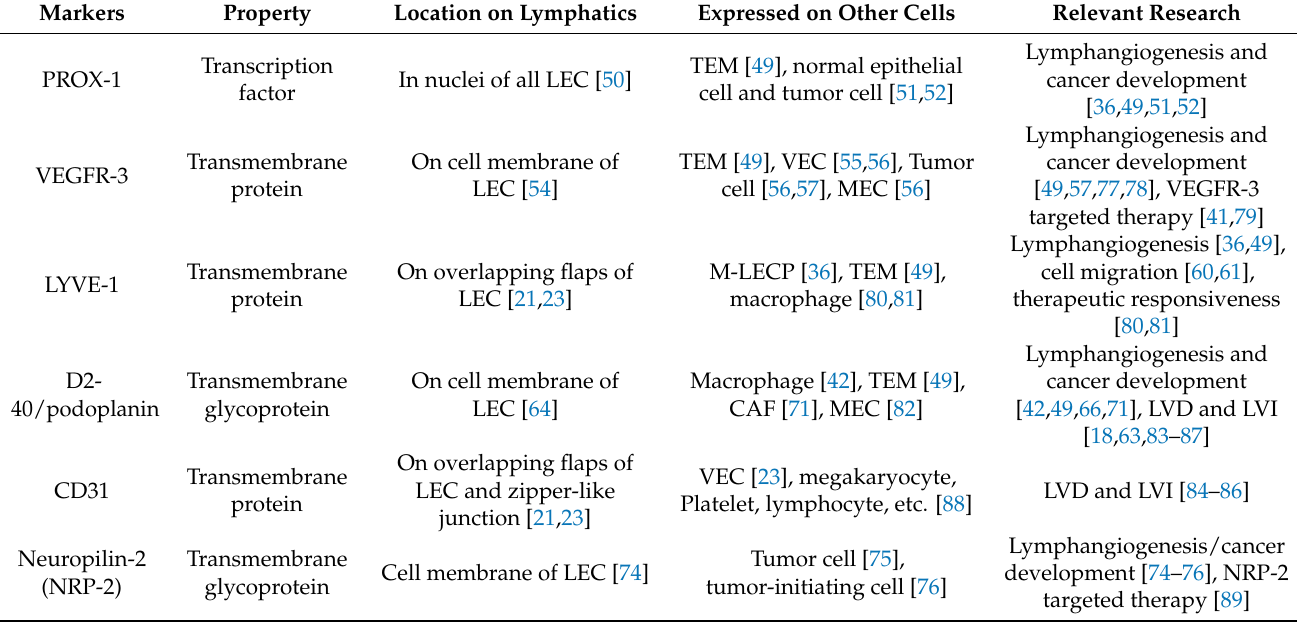
Table 1. The most commonly used lymphatic markers in breast